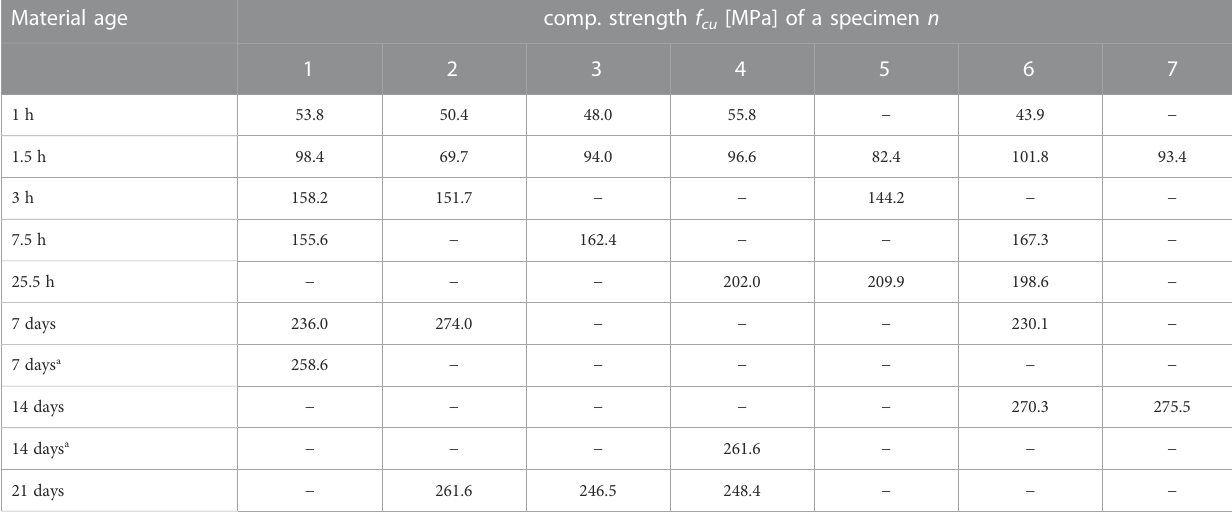
TABLE 4 Compressive strength values of the 5/10 specimens, from tests which were apparently free of signi fi cant imperfections. Material age